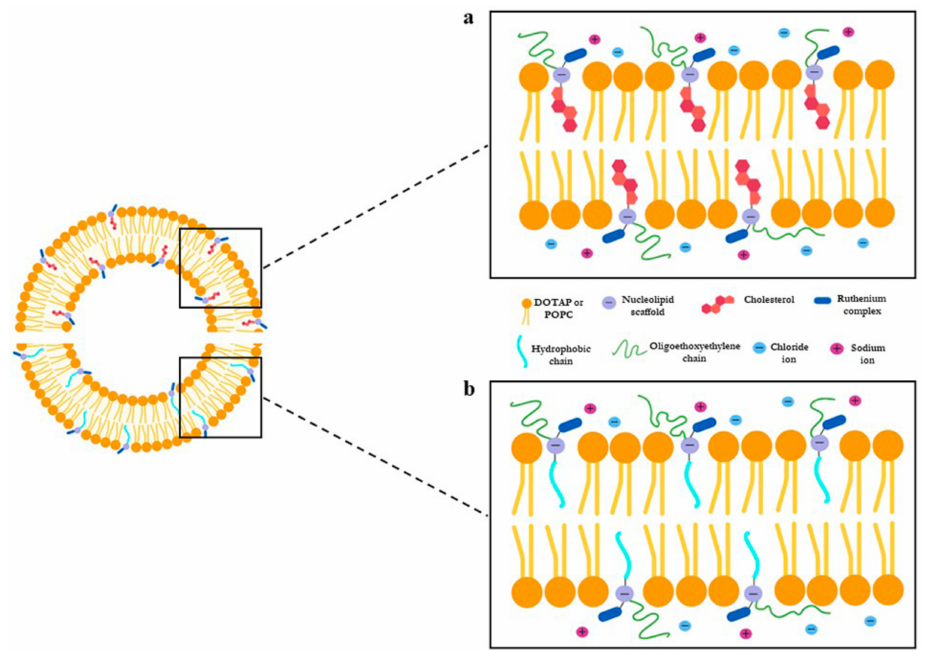
Figure 3. Qualitative molecular representation of the nucleolipid Ru(III) complexes ToThyCholRu ( a ) and DoHuRu ( b ), lodged in POPC (zwitterionic) or DOTAP (cationic) liposome bilayers, as indicated